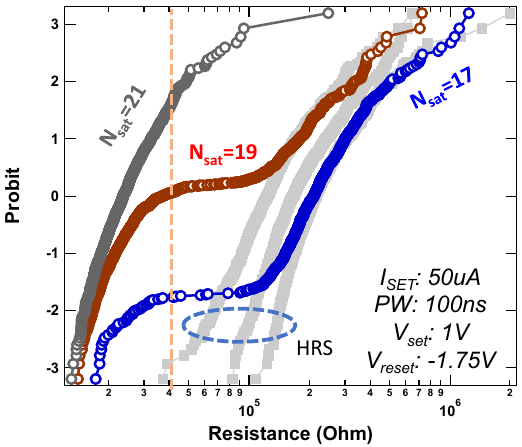
Figure 15: Simulation results of the resistance distribution after half-SET starting from different N sat values. The SET failure rate decreases as N sat increases, the threshold to determine a SET failure is 40